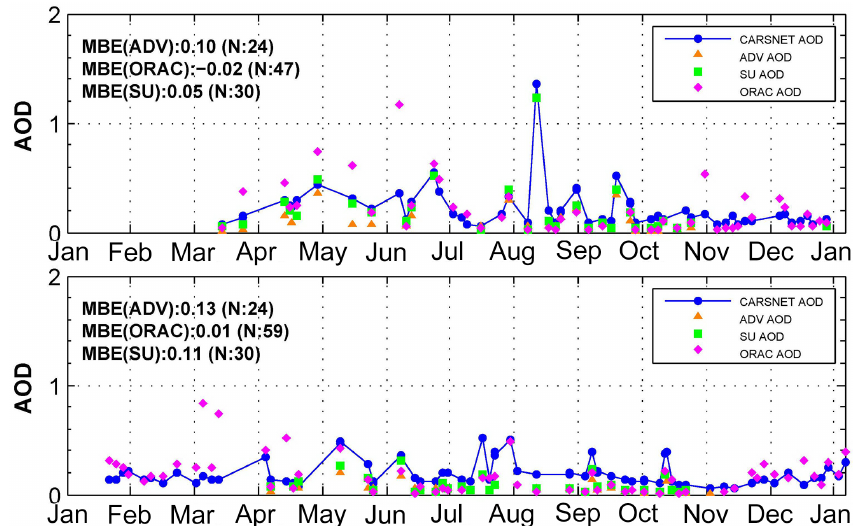
Figure 9. Comparison of SU AOD with CARSNET AOD at Xilinhot in 2008 and